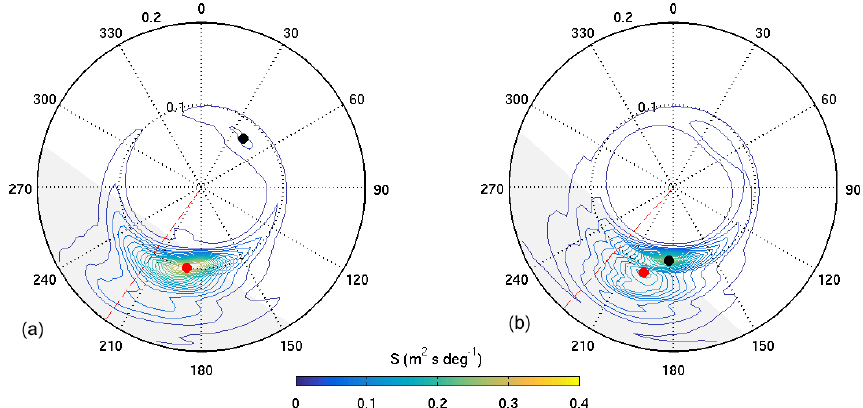
Figure A3. Observed 2D directional wave spectra measured by the WaveRider at (a) 12:45 and (b) 13:15UTC on 2 November. The radial parameter is frequency (Hz), 0 ◦ is north, and the contour lines show spectral intensity. Red circles show the main wind sea peak identified by the algorithm and black circles show the identified dominant swell. At 12:45UTC, H s , windsea = 4 . 26m and H s , swell = 1 . 25m.